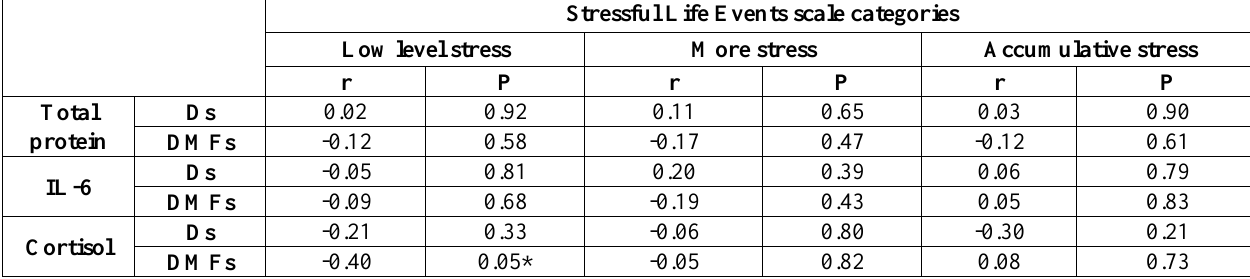
Table (5): Correlation coefficient between caries experience (DMFS, DS) and salivary constituents according to categories of Stressful Life Events scale.